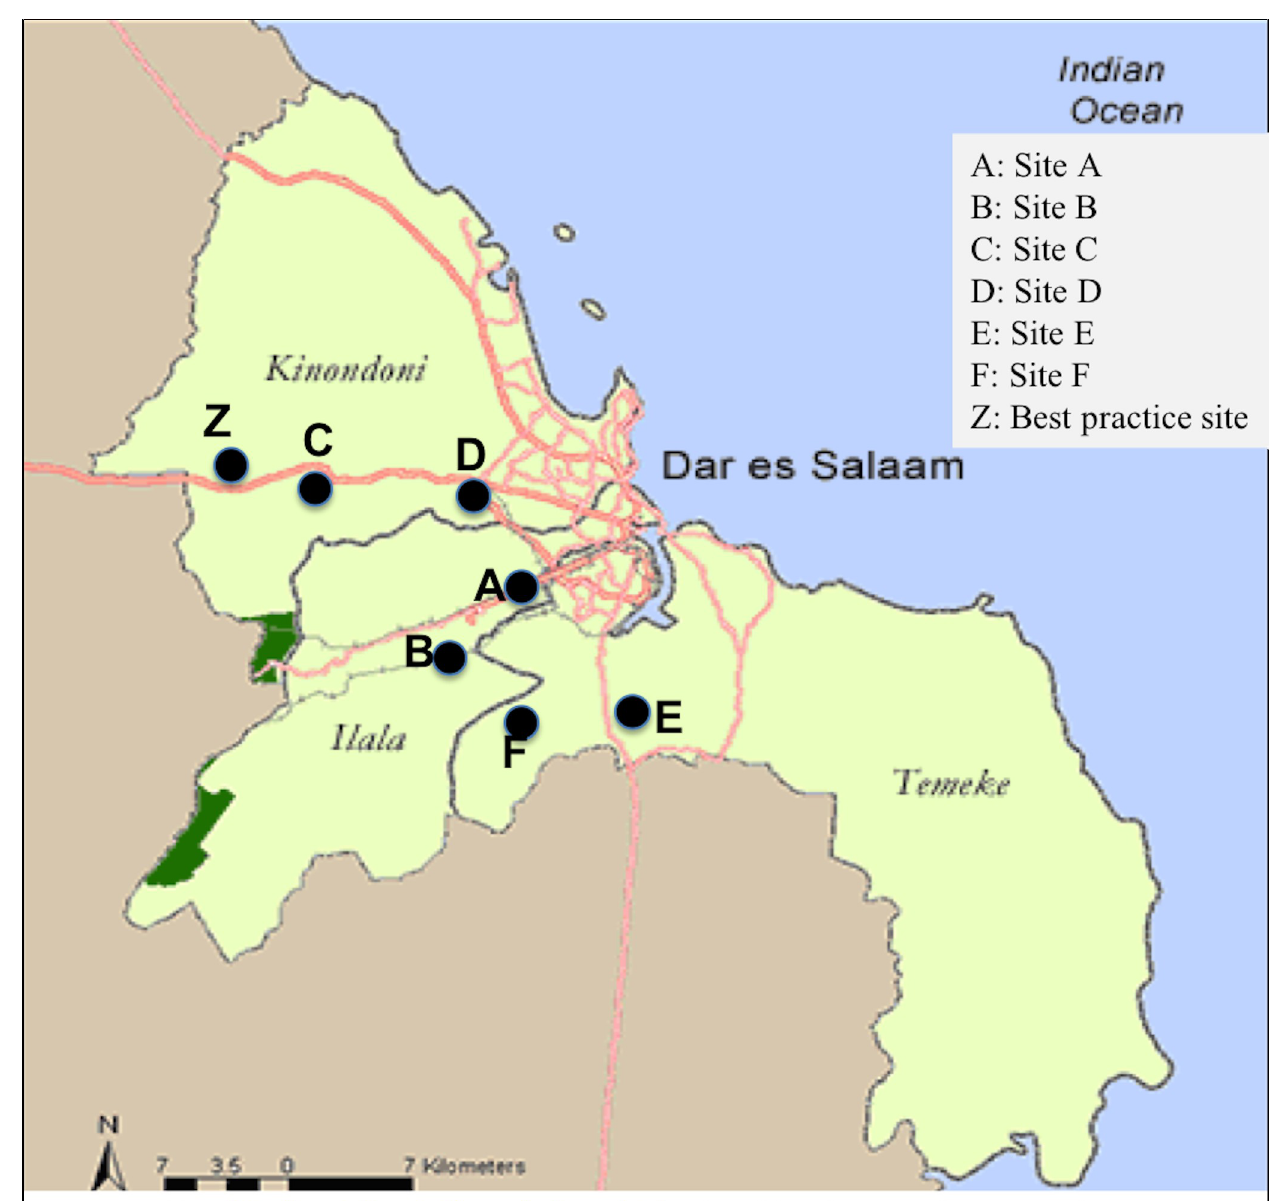
Fig 3. Map of Dar es Salaam showing location of the six intervention sites in relation to the best practice site. Reprinted from http://coastalforests.tfeg. org/tz-dar0ns.html under a CC BY license, with permission from Tanzania Forest Conservation Group (TFCG), original copyright 2006 [46].